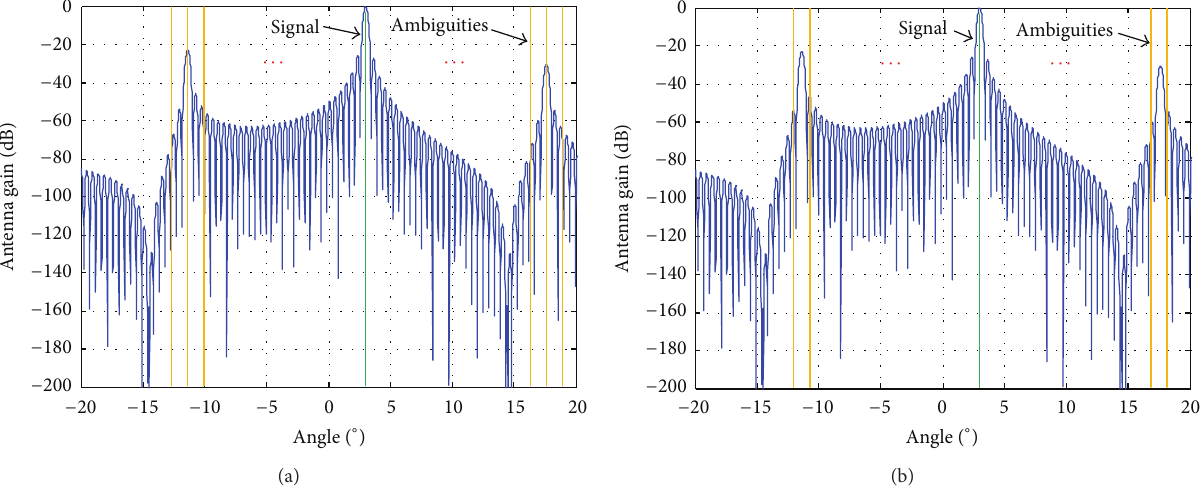
Figure 6: The impact of grating lobes with different PRF.